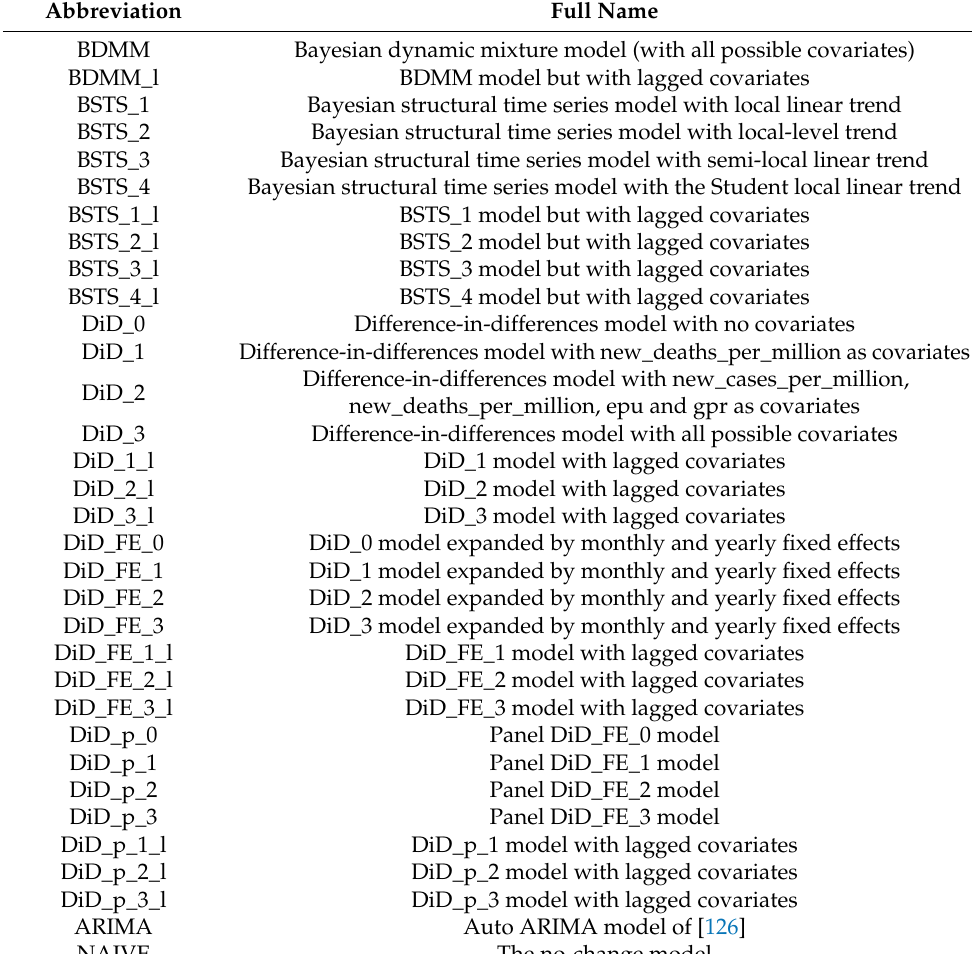
Table 2. Abbreviations of the estimated